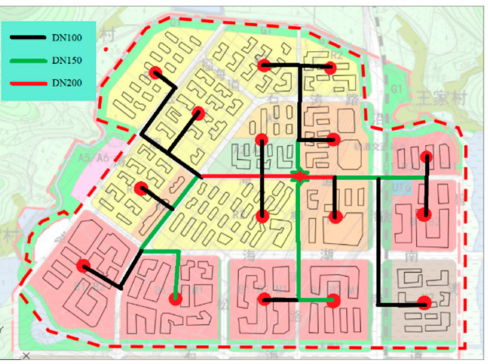
Figure 15. Optimized result when DN100 is increased by 33.1% or DN200 is decreased by